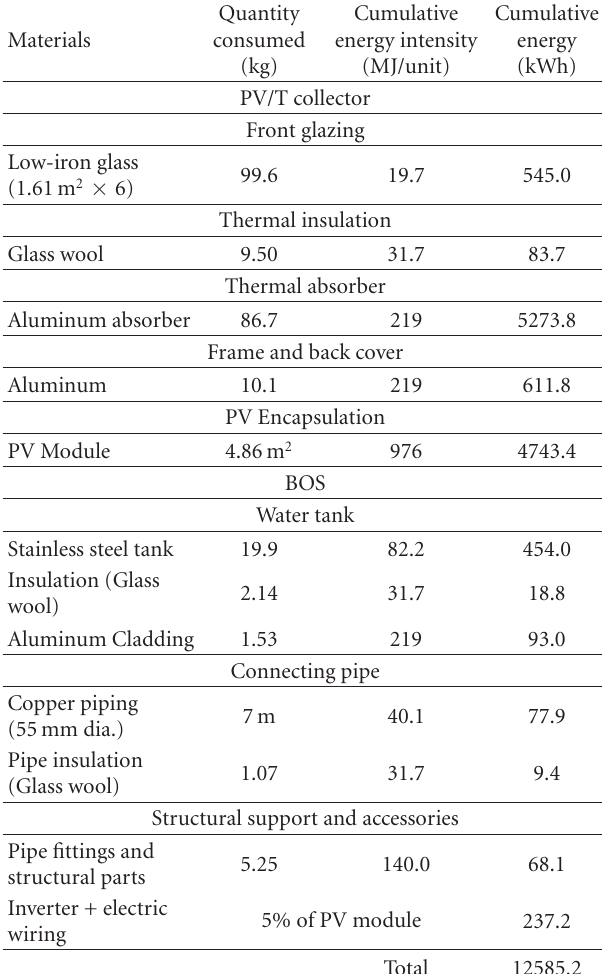
Table 5: Cumulative energy in BiPV/T